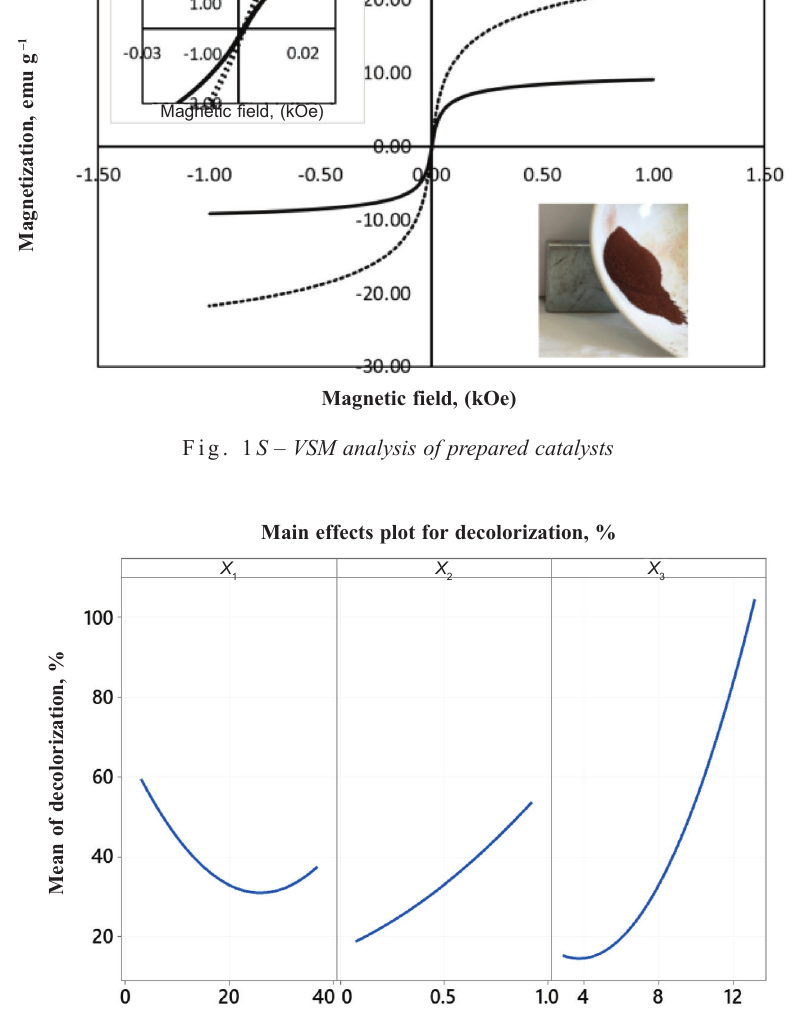
: Catalyst loading, X 2